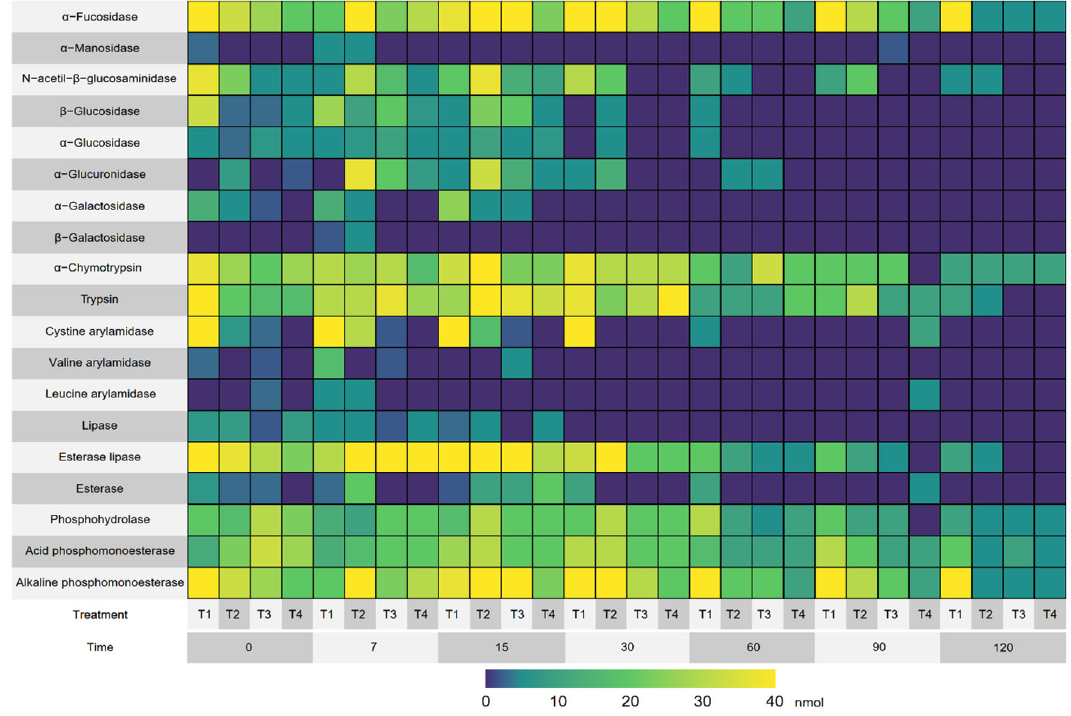
Figure 3. Enzyme profile of composting systems.